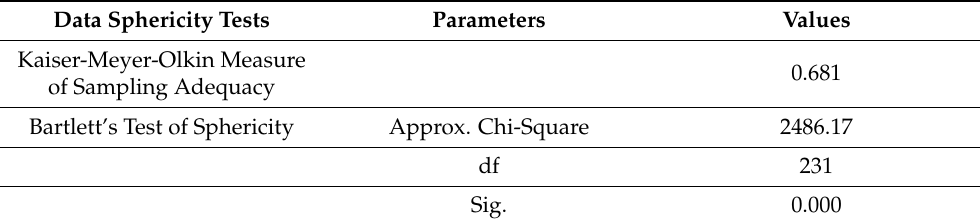
Table 2. KMO and Bartlett’s